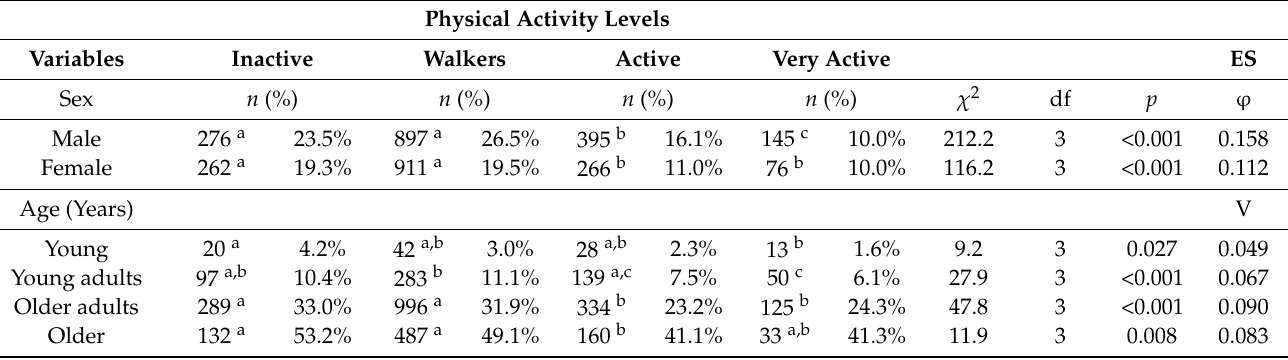
Table 4. Prevalence of hypertension by physical activity level and: sex, age and